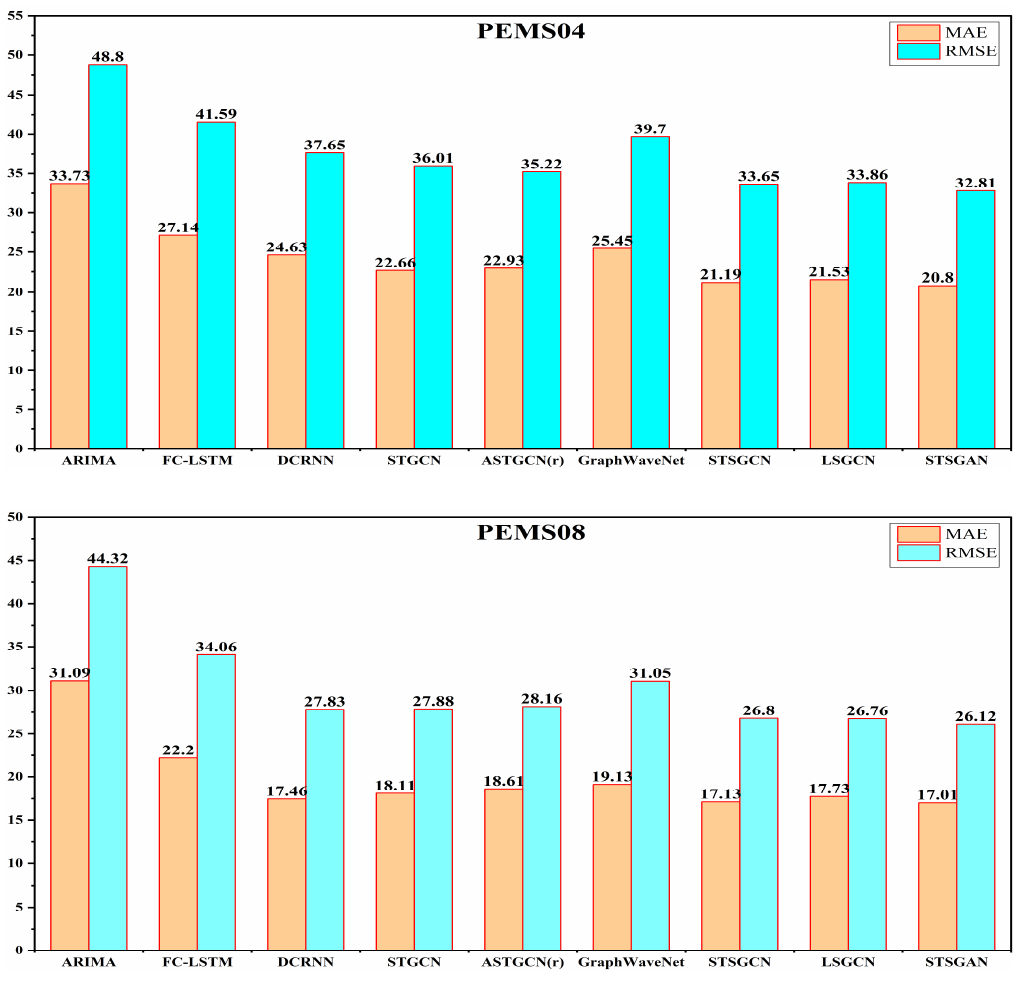
Figure 11. The subfigures PEMS04 and PEMS08 show the prediction performance of our STSGAN model on the two datasets, respectively. It is demonstrated that our method outperforms the other eight baseline models compared.